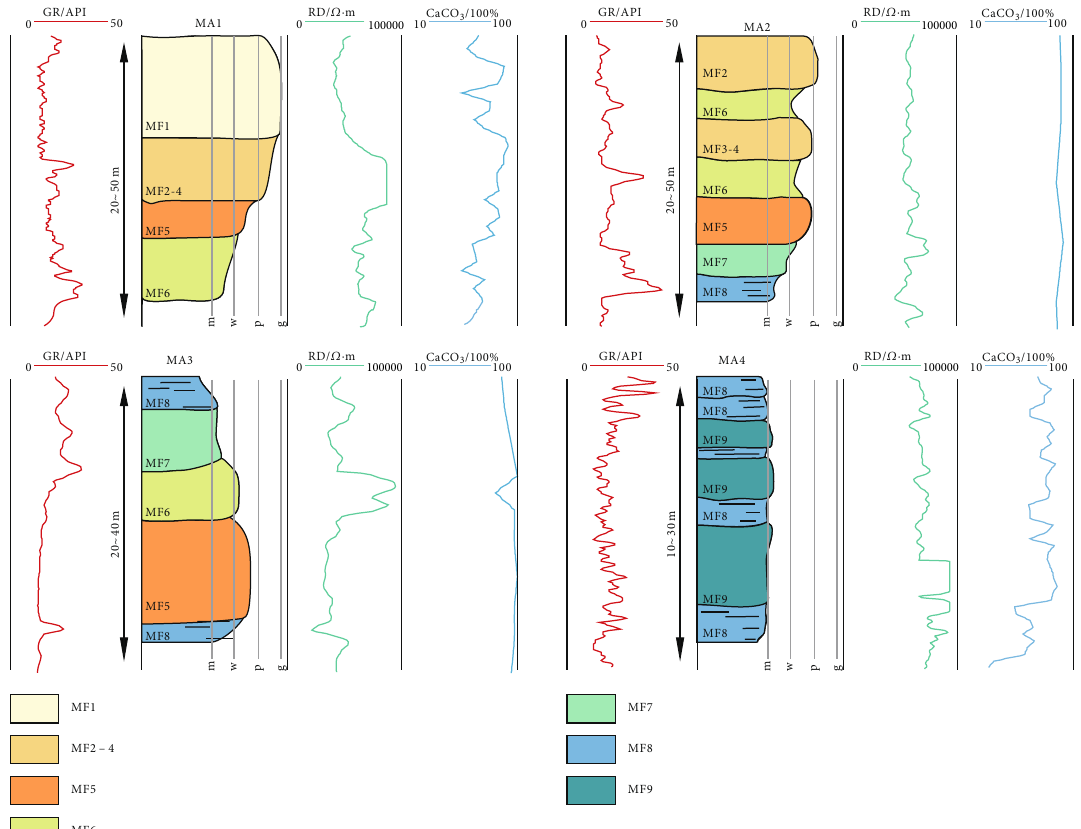
Figure 3: Microfacies associations pattern in Yingshan Formation